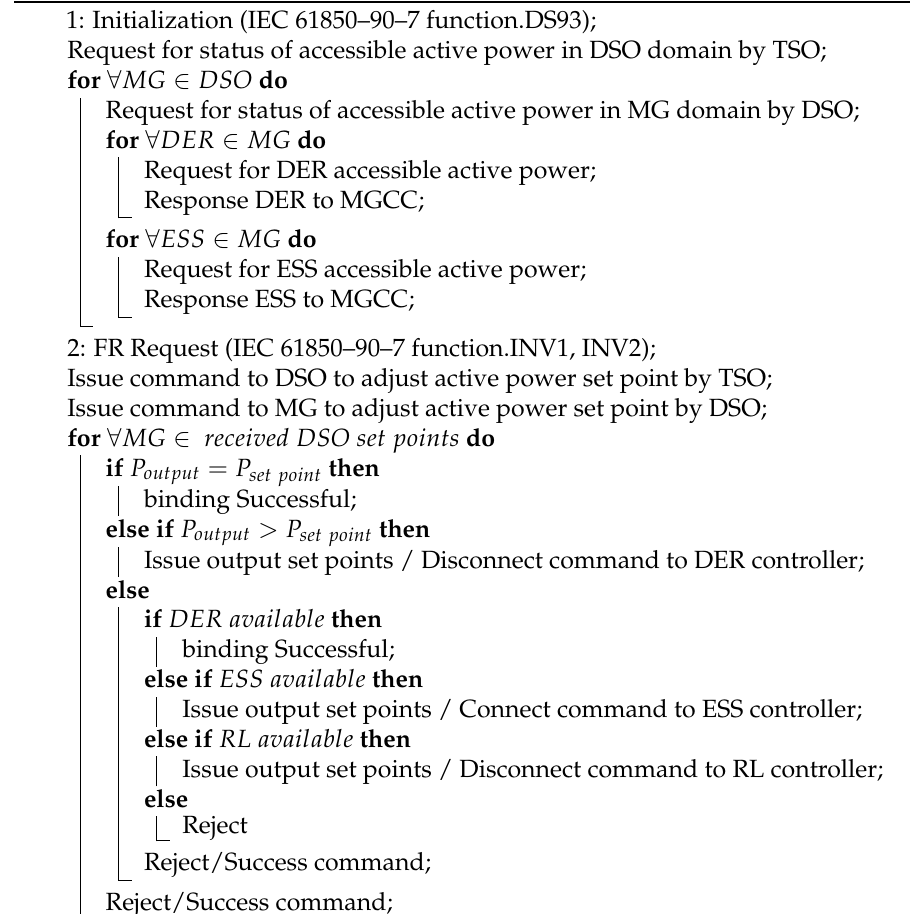
Algorithm 1: Interoperable algorithm for contribution of the MG in the utility grid FR based on IEC